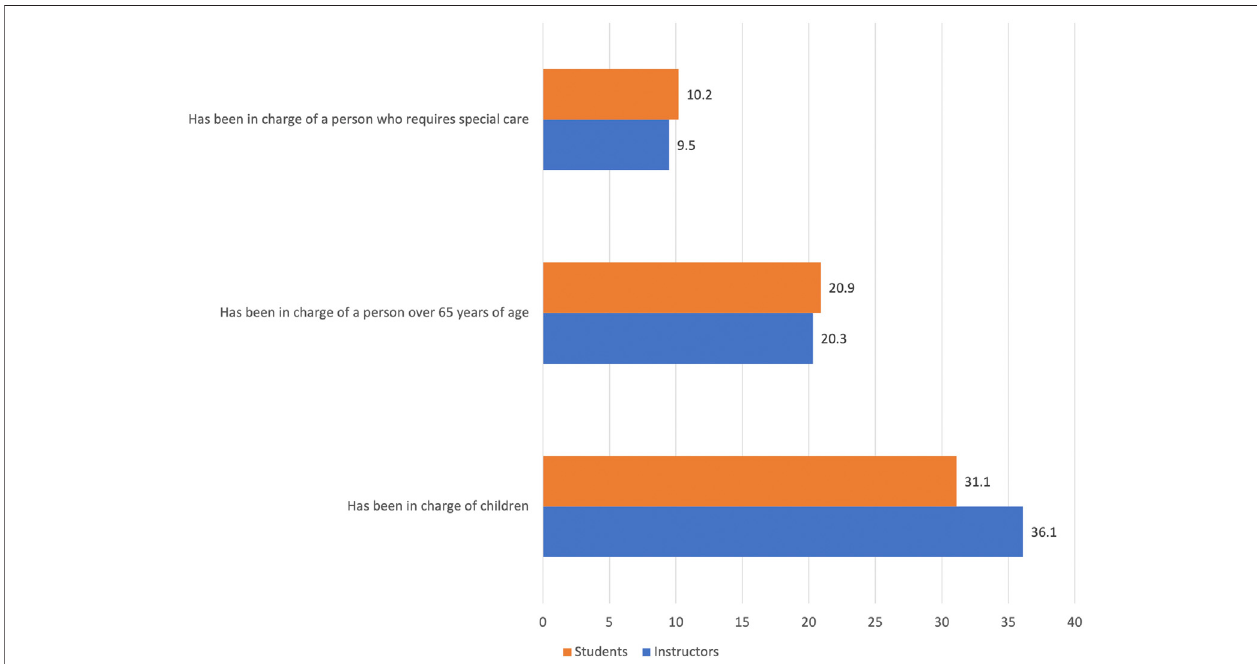
FIGURE 2 | Care of children, people over 65, and people who need special